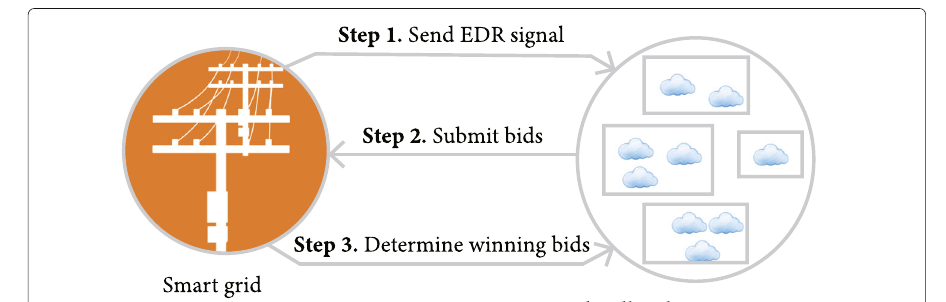
Fig. 1 A demonstration of EDR via cloudlet clusters